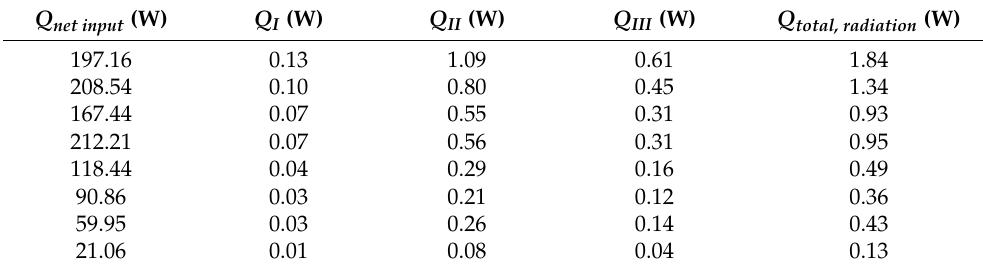
Table 8. Total heat transfer from the surface of the pipe.